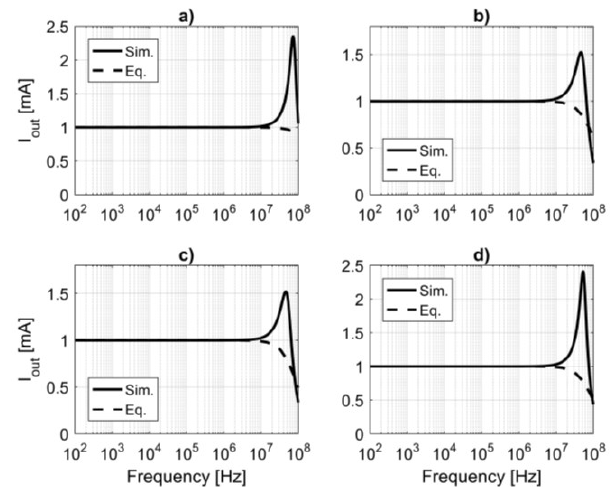
Fig.12: Simulated and calculated output current for 1 Ω load. a) QUAD b) DIF_C using inverting input c) DIF_C using non-inverting input d) DIF_M.